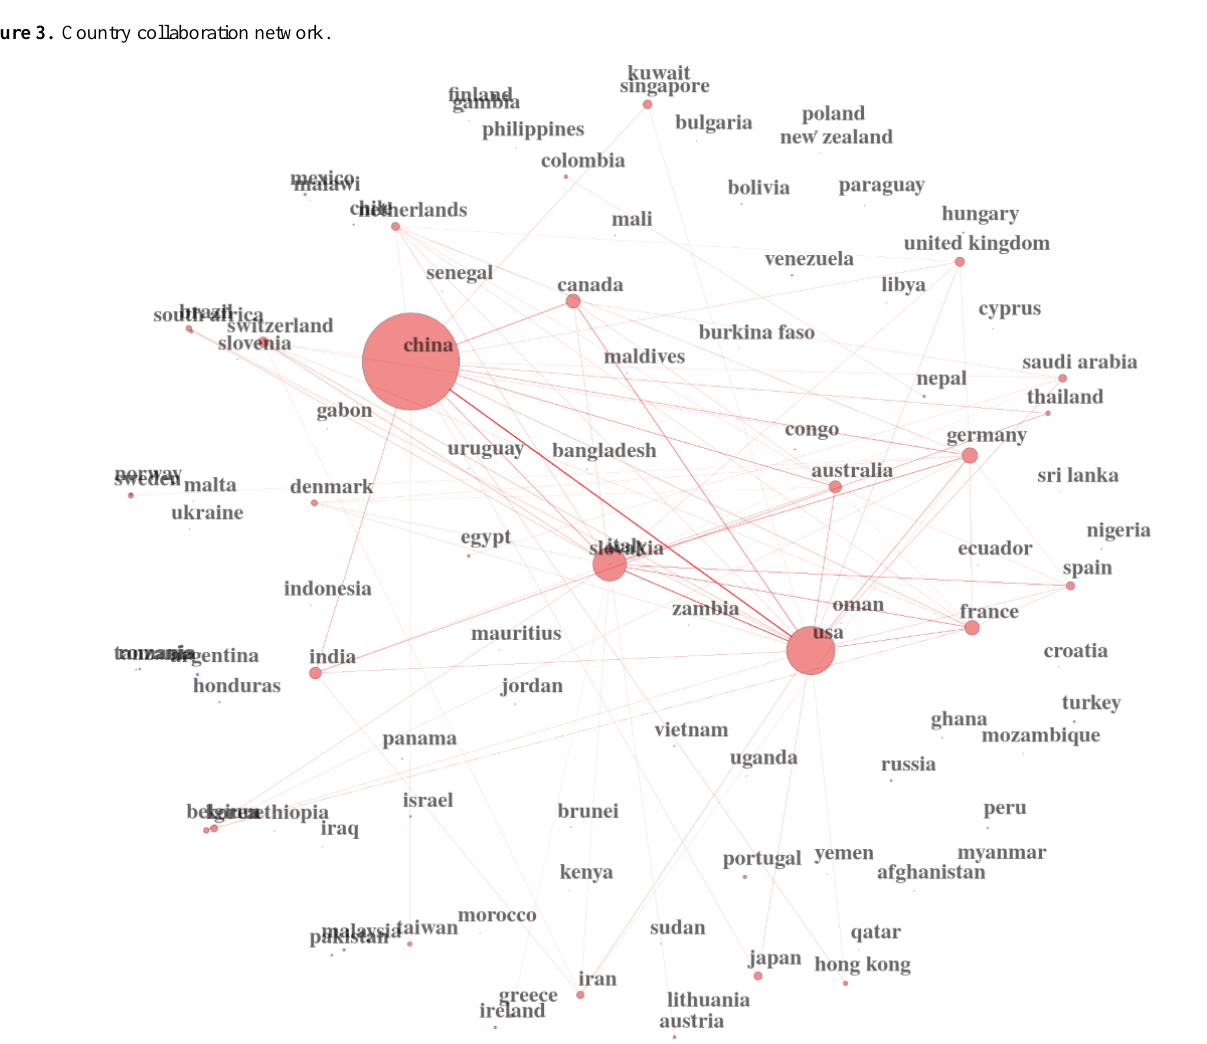
Figure 4 is an illustration of author collaboration networks. As previously mentioned, we remain at a very high level